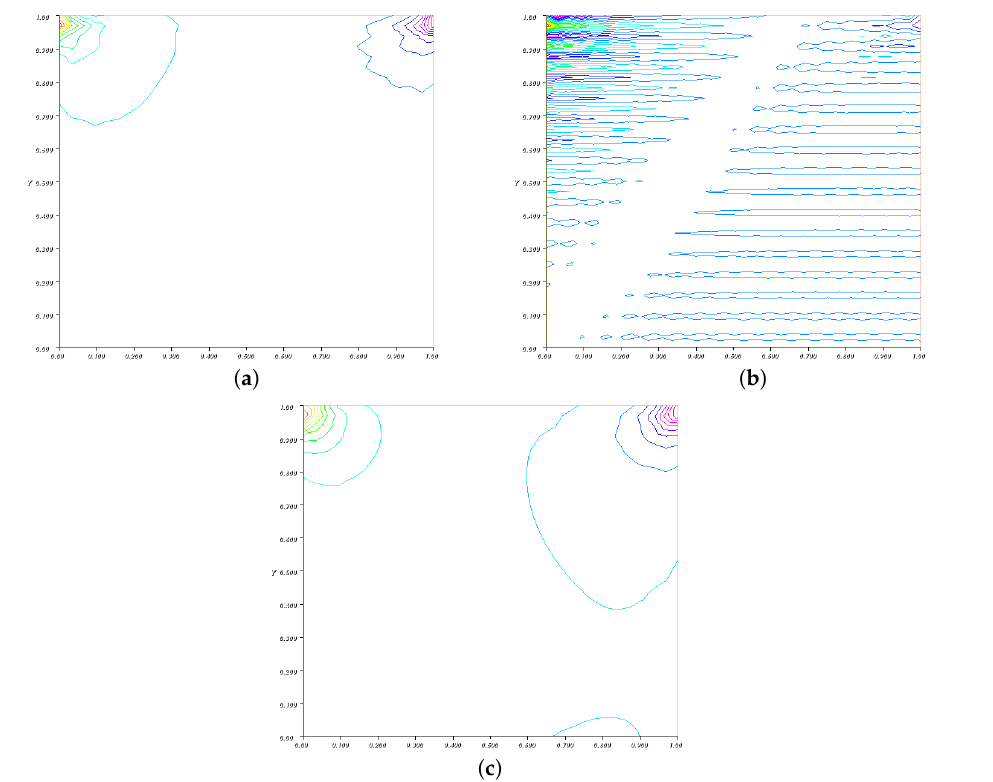
Figure 3. Comparison results are presented to the pressure contours for the viscoelastic cavity. From left to right: ( a ) P 1 b - P 1- P 1, standard, ( b ) P 1- P 1- P 1 without stabilization shows oscillation and ( c ) P 1- P 1- P